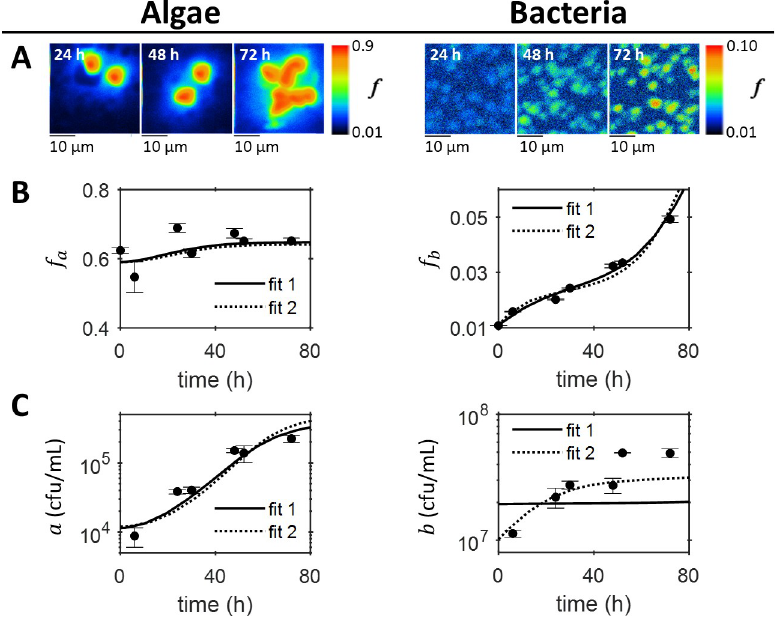
Fig 3. The algal-bacterial co-culture. (A) Example images of the atomic fraction of 13 C , f , obtained by SIMS analysis of algal and bacterial cells sampled from the co-culture. The colour maps show the scale, starting at natural abundance. (B) The mean atomic fraction of 13 C , f a and f b for algae and bacteria respectively, calculated from the dilution- corrected SIMS measurements for at least 5 algal cells and 100 bacterial cells per time-point (circles). Error bars correspond to standard errors. (C) Algal and bacterial growth measured using viable counts, plotted as the mean (with standard error shown as error bars) of two viable count measurements (circles). The results of fitting the model to both the growth and SIMS data are also plotted. Fit 1 fixed the initial f (0) = 0.64, estimated using results for the pre- o labelling culture of algae, whereas fit 2 included f o (0) as a free parameter. The parameter values and initial conditions are as specified in Table 1 and S8 Table. Although fit 2 fits the data better, it gives a low initial atomic fraction for the DOC f o (0) and high initial DOC concentration c o